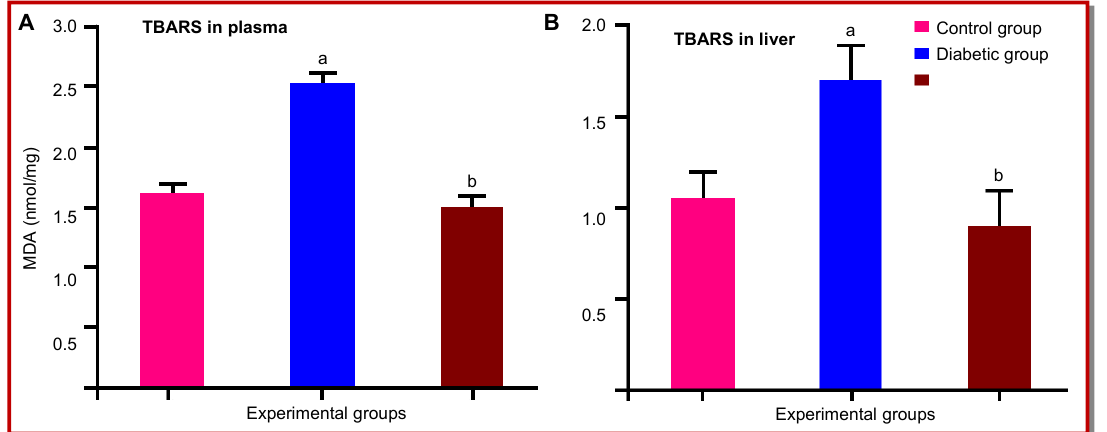
Figure 1: (B) TBARS levels in liver tissues of various experimental groups. a p<0.001 compared to control group; b p<0.001 com- pared to diabetic